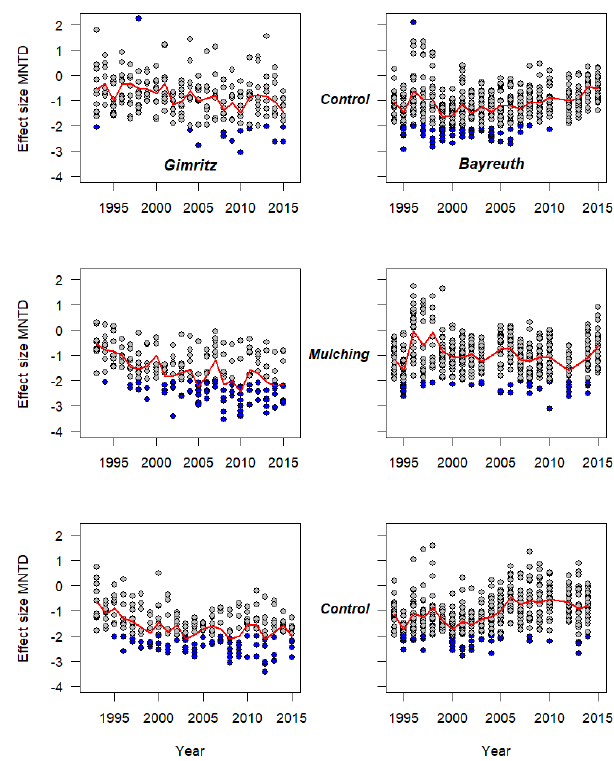
Figure 5. Trajectory of the effect sizes of the mean phylogenetic mean nearest taxon distances (MNTD) of plant communities within subplots for each treatment in Gimritz and Bayreuth. For details on calculating the effect sizes see Material and Methods. Symbols in blue indicate significant mean effect sizes. The red line gives the mean effect sizes of the